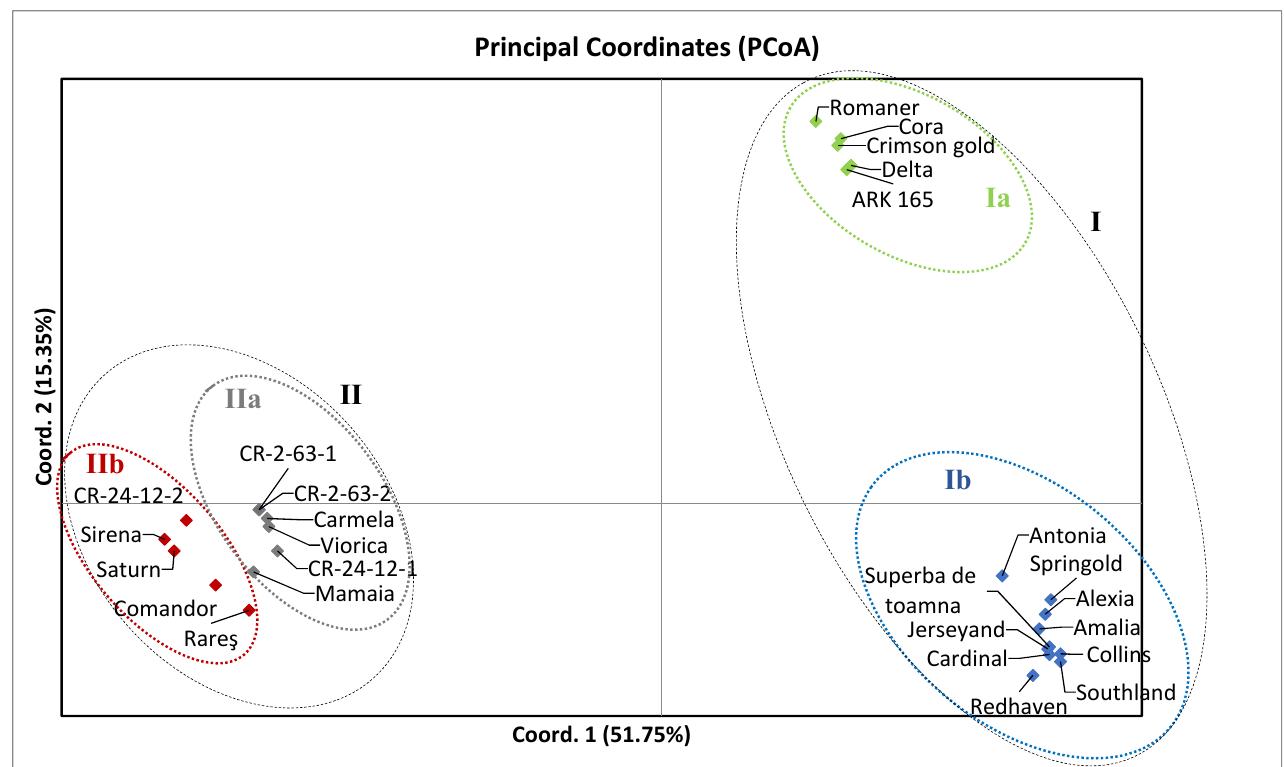
Figure 2. A two-dimensional plot of the Principal Coordinate Analysis (PCoA) of SSR data showing the clustering of 26 Prunus cultivars: 10 peach (cluster I, subcluster Ia), 5 nectarine cultivars (cluster I, subcluster Ib) and 11 apricot cultivars (cluster II with two subclusters: IIa and IIb). Generated with GENALEX 6.5 program [43].